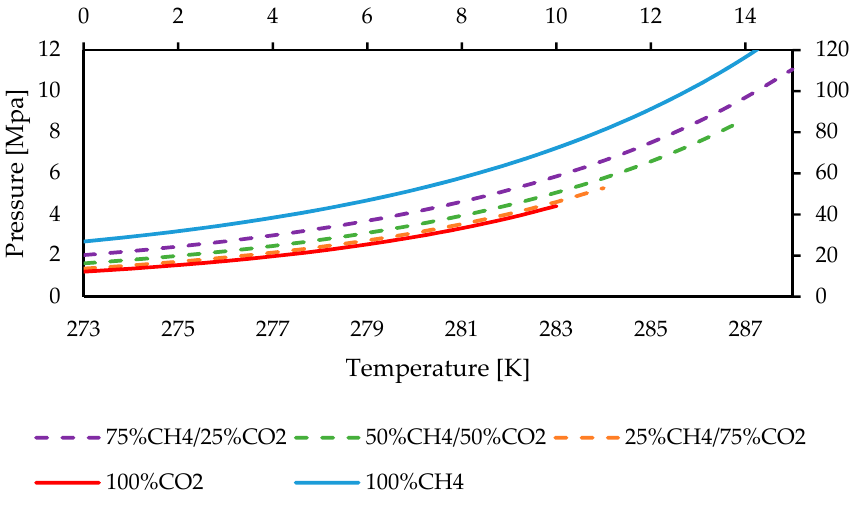
Figure 12. Hydrate phase equilibrium of a mixture of carbon dioxide and methane from Equation (8).